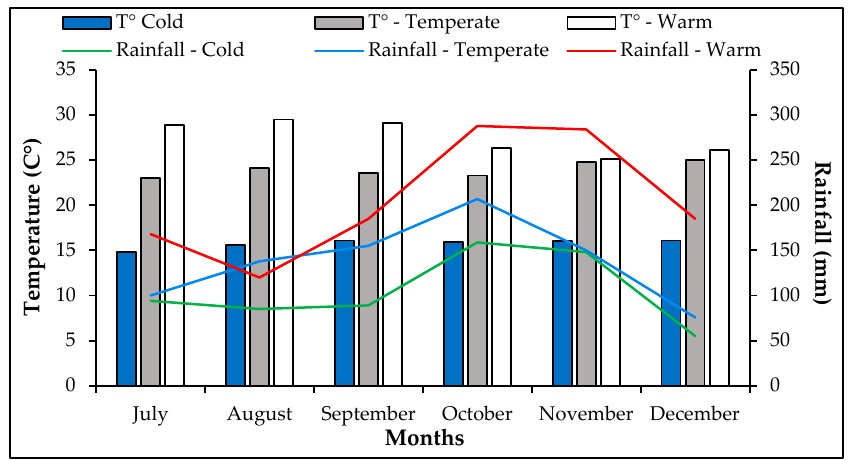
Figure 1. Climatic conditions of the three study regions.